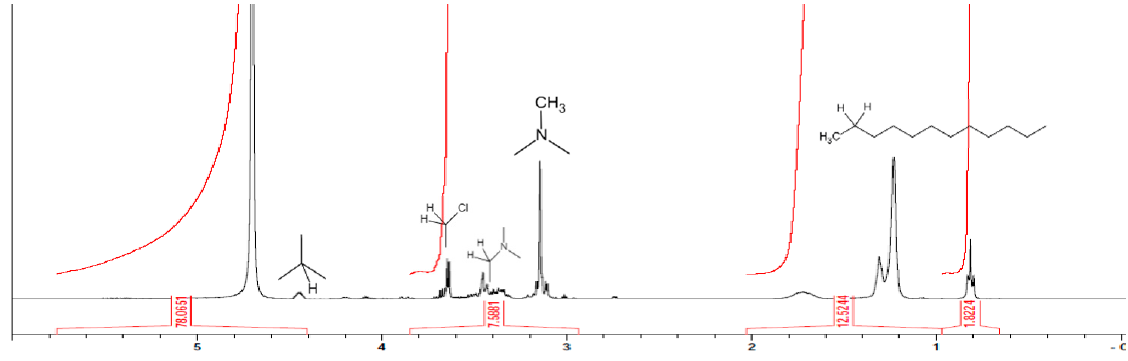
Figure 3. NMR spectra of (3-chloro-2-hydroxypropyl) chloride. After making thin sheets of cotton floss with KBr, the structure of cotton floss was analyzed by Fourier transform infrared spectroscopy (FT-IR). The results are shown in Figure 4. It can be seen that the modified cellulose had a more obvious peak at 1637 cm − 1 and 2900 cm − 1 than pure cellulose. The peak at 1637 cm − 1 was generated by the variable angular vibration of the quaternary ammonium group, and the peak at 2900 cm − 1 was generated by the stretching vibration of methylene in the long-chain dodecyl group [28,29]. This confirmed that the quaternary ammonium group had modified the cellulose.